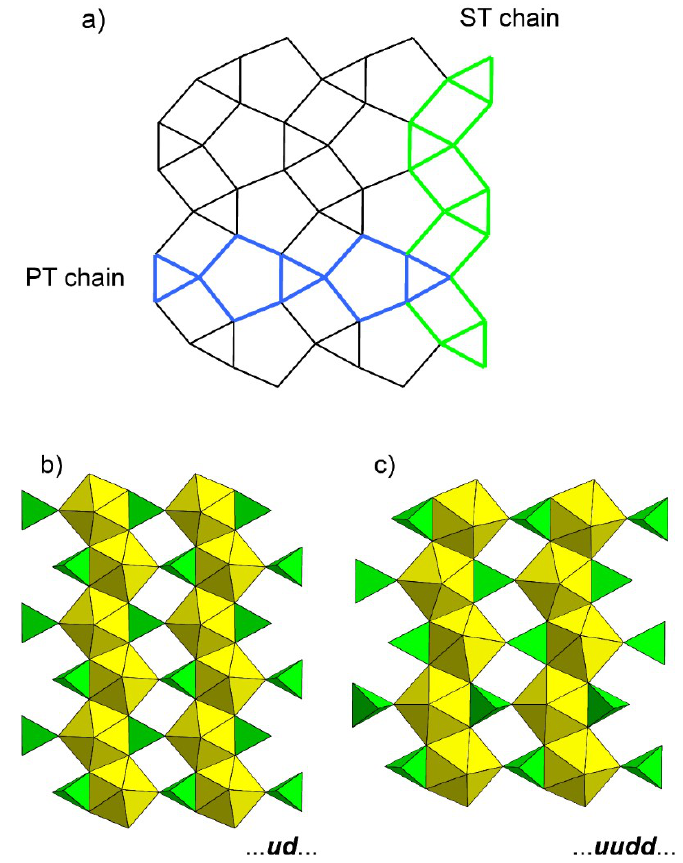
Figure 3. Uranophane uranyl-anion topology. ( a ) Its graphical representation with indicated pentagons-triangles (PT, blue) and squares-triangles (ST, green) chains. ( b ) Uranophane-α sheet projected onto (100). ( c ) uranophane-β sheet projected onto (010). UO 7 bipyramids are in yellow; SiO 4 tetrahedra are in green. The corresponding ST sequences are given .